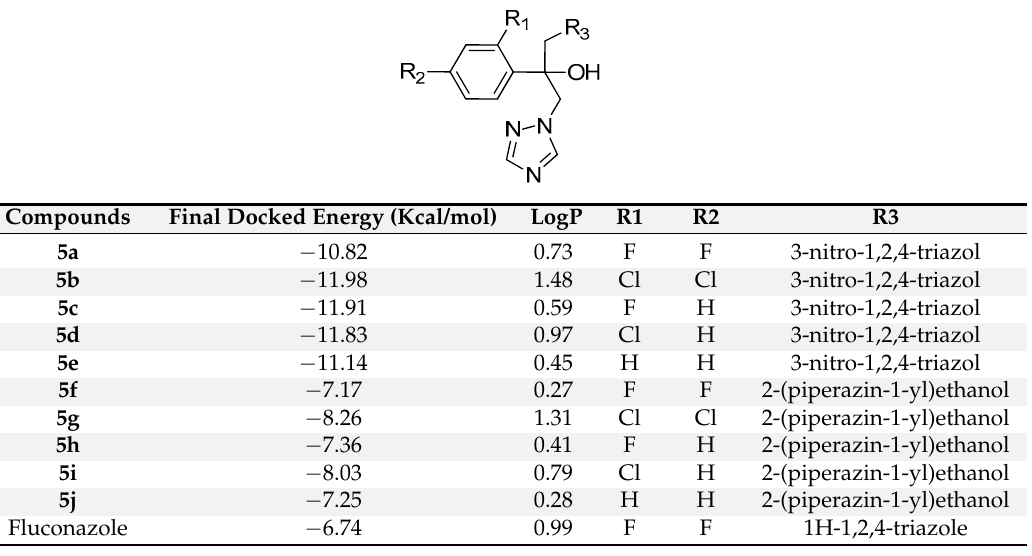
Table 3. Docking results for compounds 5a – j into the active site of 14 α -demethylase enzyme (1EA1).